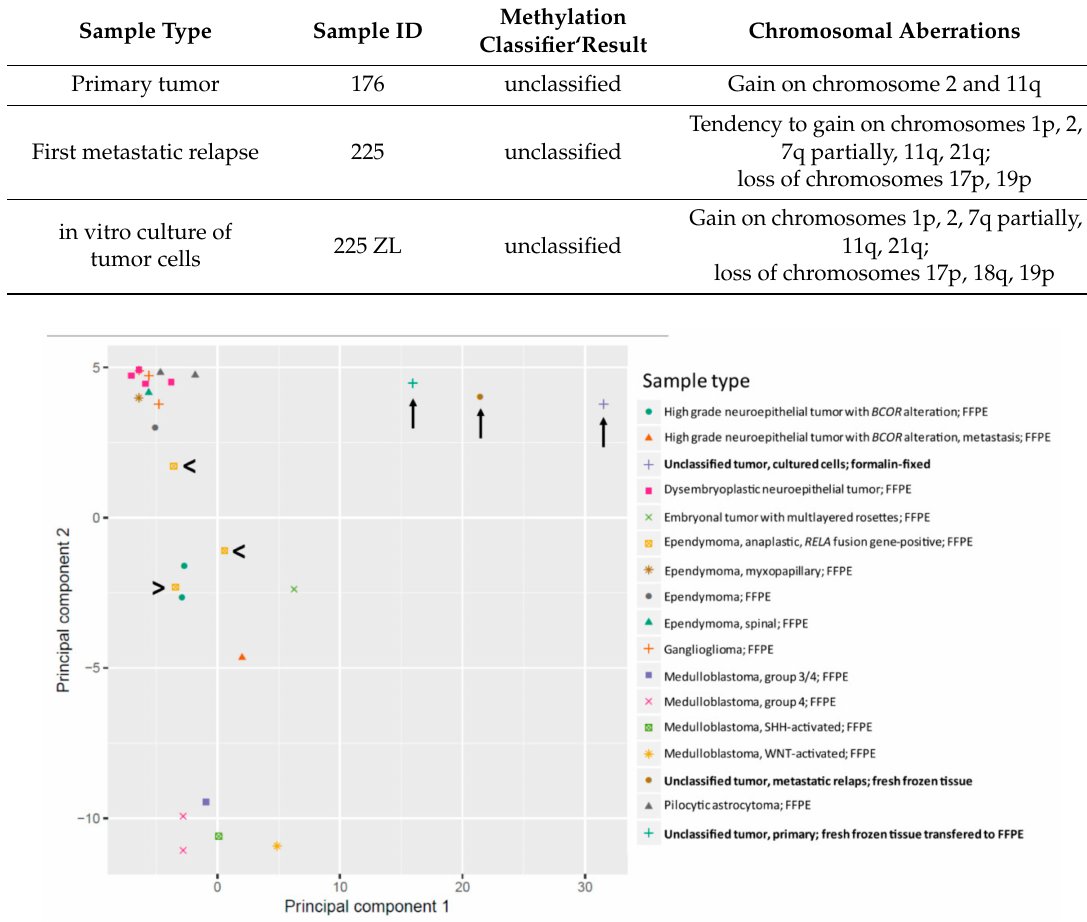
Figure 2. Principal Component Analysis. Principal component analysis by genes based on 850 k DNA methylation analysis for di ff erent tumor entities commonly found in childhood. Samples of the index patient do not cluster together with ependymoma, RELA fusion-positive tumors (arrow heads), but rather form their own cluster (arrows). The kind of material used for the analysis is indicated (fresh frozen or formalin-fixed, para ffi n-embedded